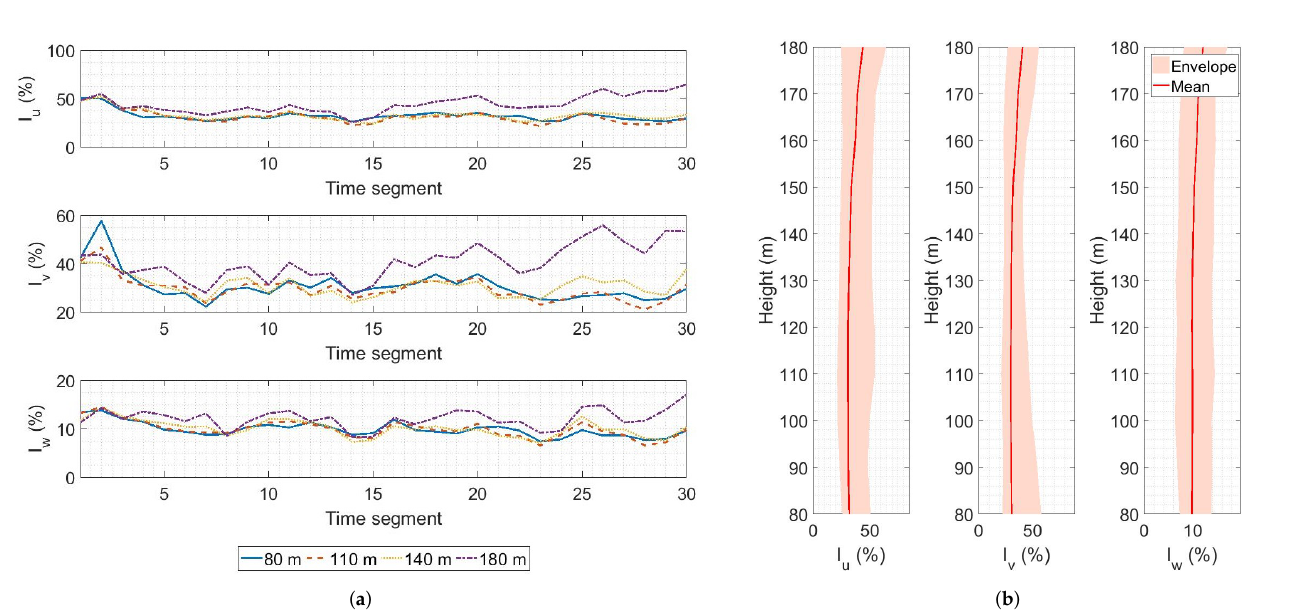
Figure 9. Wind episode 5 on 4 December 2019: ( a ) time evolution of turbulence intensity components at four different heights above the ground. Each time segment represents 10 min interval; ( b ) vertical profiles of turbulence intensity components during all time intervals, represented by their envelope and mean.